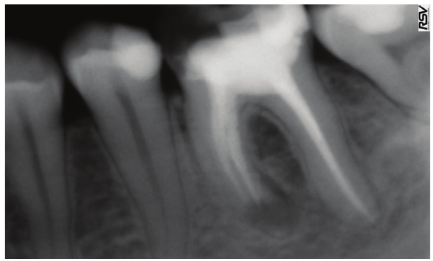
Figure 1: Initial radiograph.